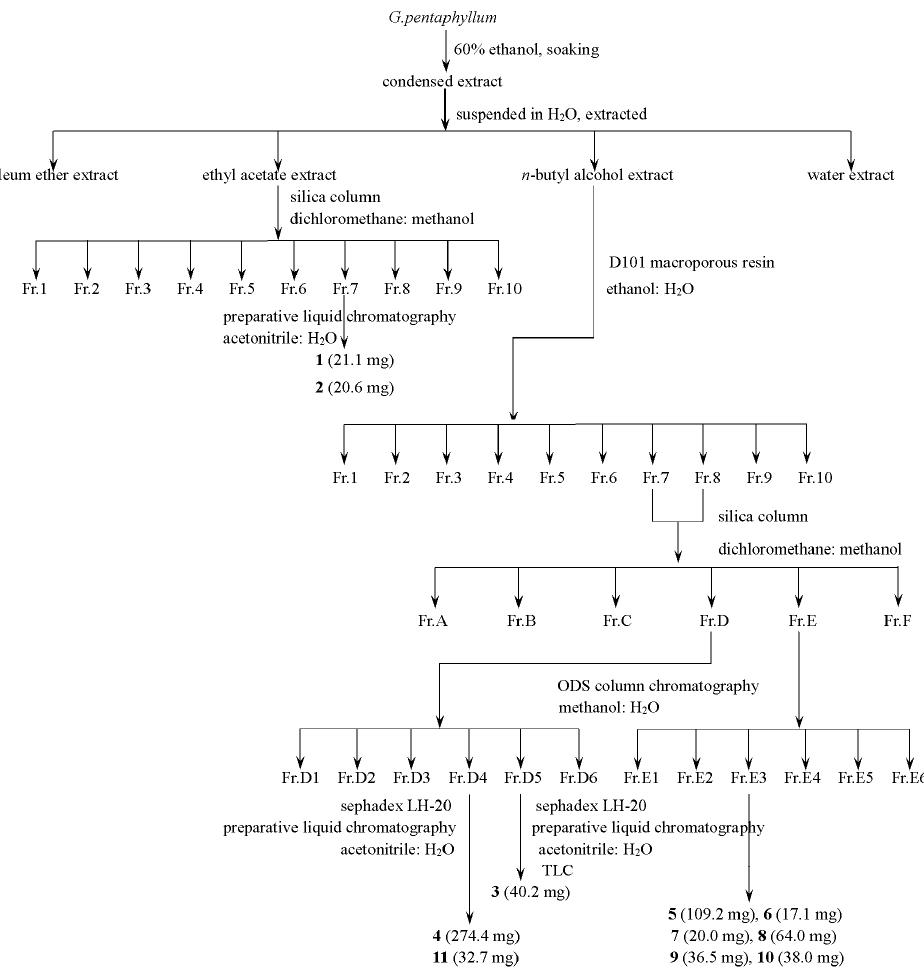
Figure 5. Scheme illustrating the entire isolation